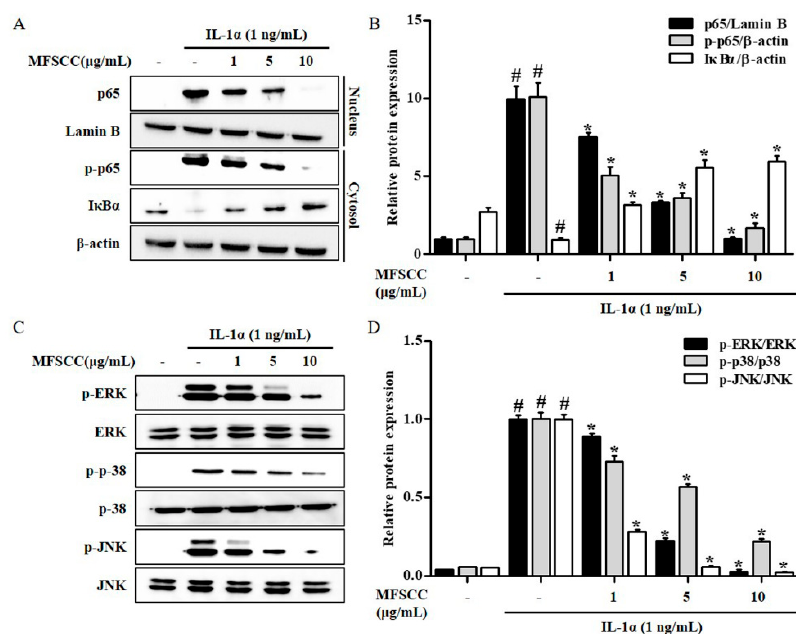
Figure 3. MFSCC inhibited IL-1 α -stimulated phosphorylation of NF- κ B and MAPKs signaling pathway. ( A , B ) The protein levels of p65, p-p65, and I κ B α were detected by western blot. ( C , D ) The levels of phosphorylated ERK, p38, and JNK were determined by western blot. The rat primary chondrocytes were co-treated with MFSCC (0, 1, 5, and 10 μ g/mL) and 1 ng/mL IL-1 α for 24 h. The data are indicated as mean ± SEM (# p < 0.05 compared with the control group; * p < 0.05 compared with the IL-1 α